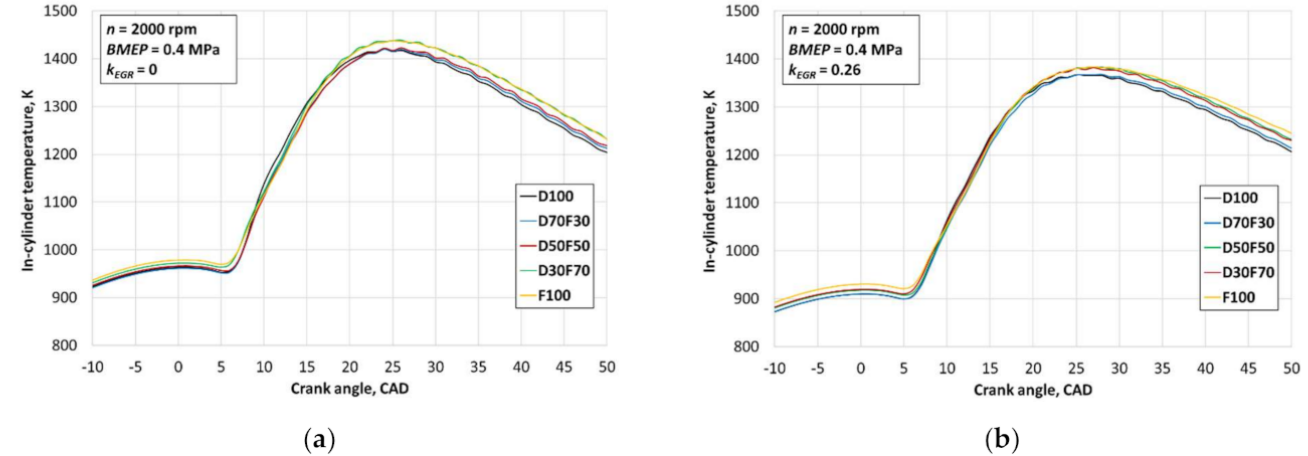
Figure 4. In-cylinder temperature, depending on fuel composition with ( a ) EGR off and ( b ) EGR on. The highest pressure rise in the premix combustion phase was achieved using pure diesel (~0.12 MPa/CAD with EGR off and ~0.08 MPa/CAD with EGR on) (Figure 5). For D70F30, the pressure rise in the premix phase decreased ~17% with EGR off and ~27% with EGR on, declining ~30% and ~35% for D50F50, ~46% and ~43% for D30F70 and ~62% and ~60% for F100, respectively. With EGR off and on, the maximum temperature rise was achieved at 8 CAD ATDC for all fuel mixtures. When increasing the chicken fat concentration in the fuels, the pressure rise declined in the premix phase and moving to the diffusion phase, which reduced the load on the engine parts and the evolved